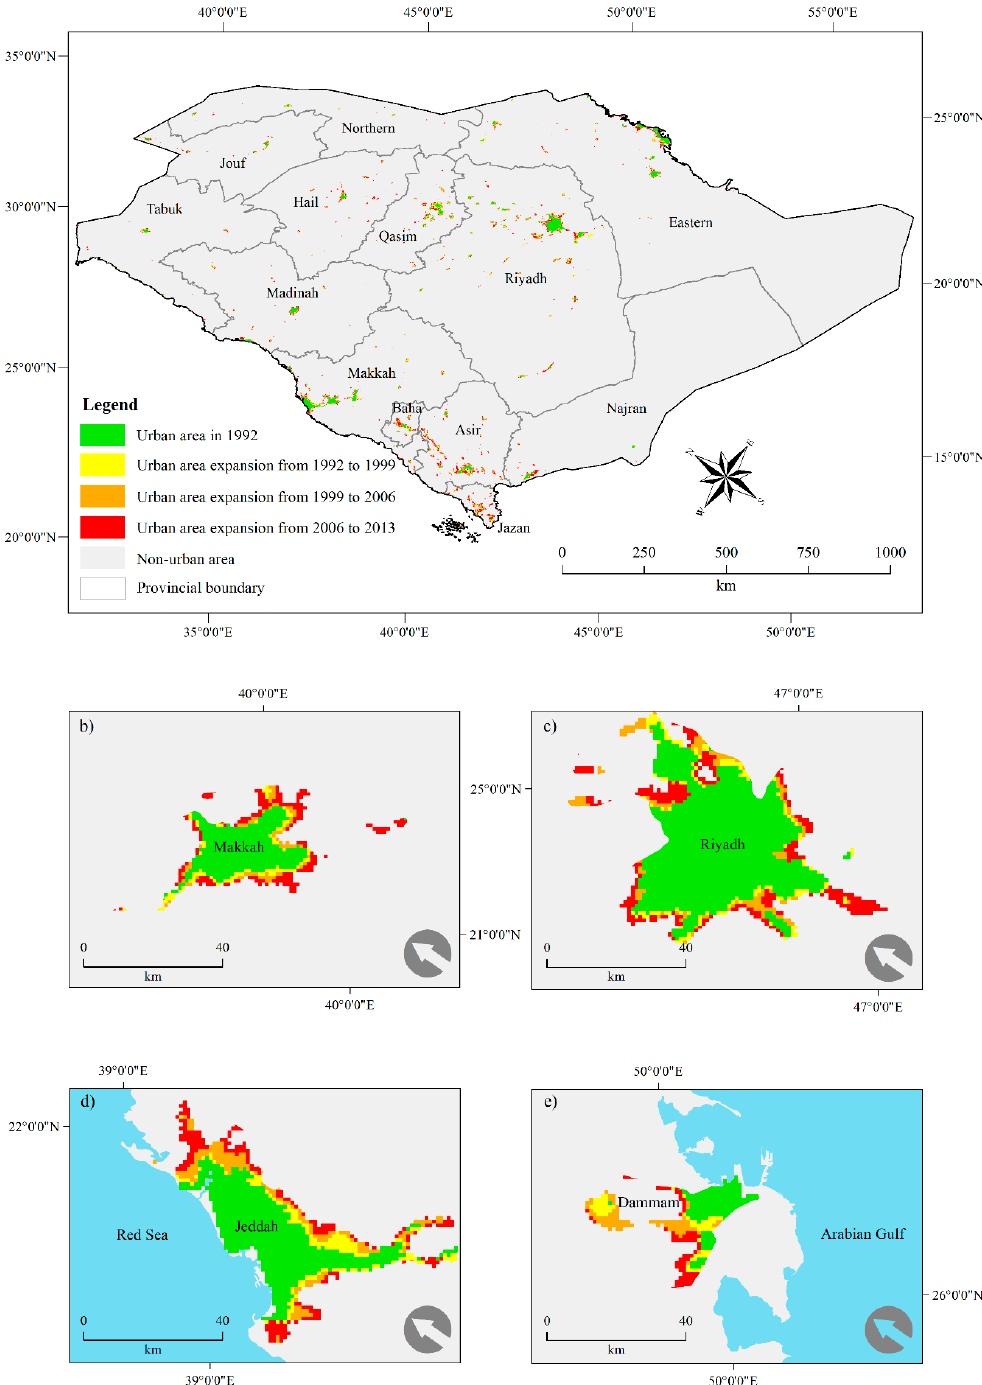
Figure 11. Dynamics of urban expansion through three time periods (1992 to 1999; 1999 to 2006; 2006 to 2013) in ( a ) Saudi Arabia and ( b – e ) highly urbanized cities.